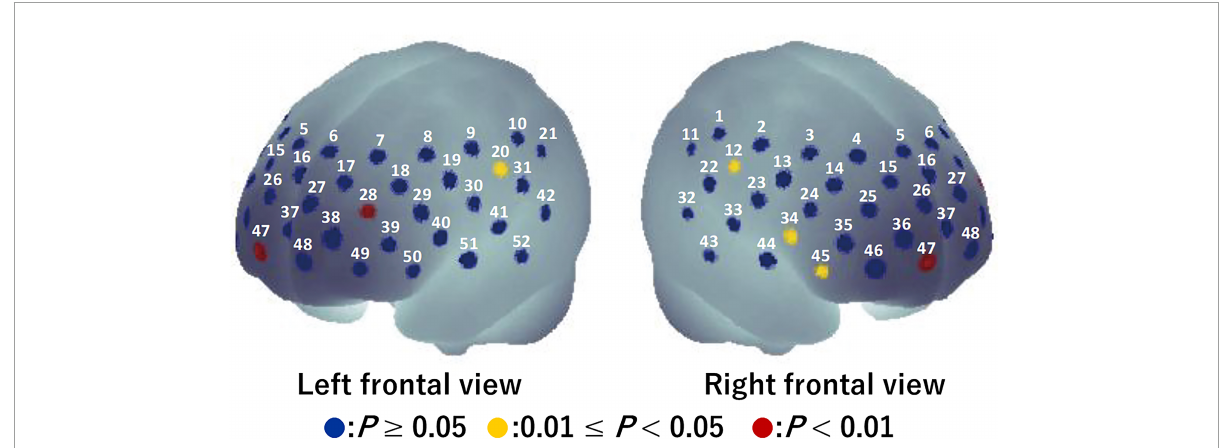
FIGURE4 Activation map during Go/NoGo blocks in the visual task before watching a 1-h movie using a one-tailed one-sample t -test. Blue circles indicate P ≥ 0.05, yellow circles indicate 0.01 ≤ P < 0.05, and red circles indicate P <